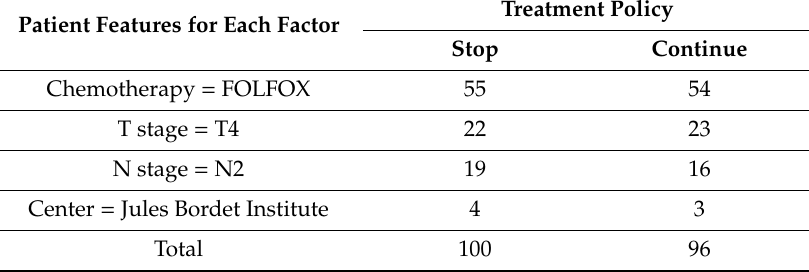
Table 2. Example of minimization in a trial for which the next patient to be entered has the features shown in the first column, whereas the remaining columns show the numbers of patients with each of the features already randomized to each arm. “Total” does not refer to total number of patients in each arm, but rather to the imbalance explained in the